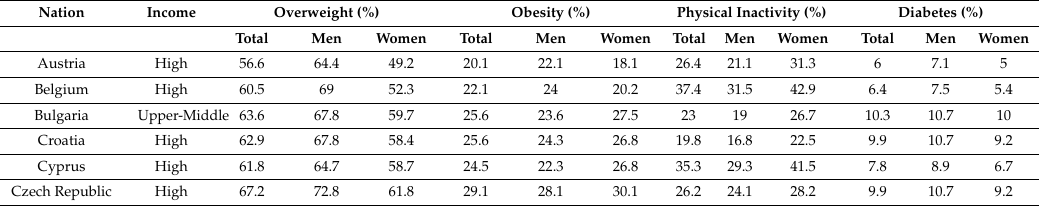
Table 1. Distribution percentages of risk factors